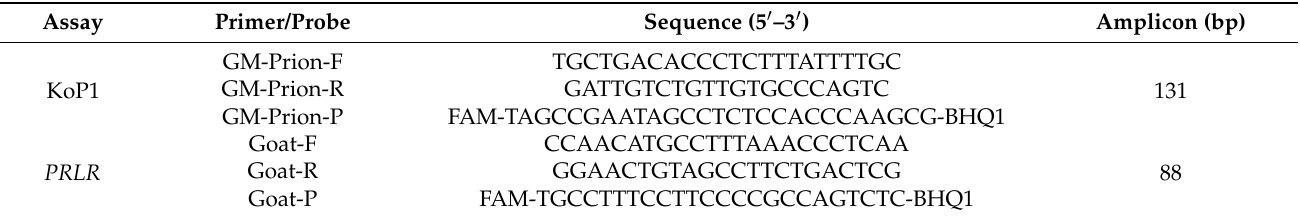
Table 1. List of primers and probes for ddPCR